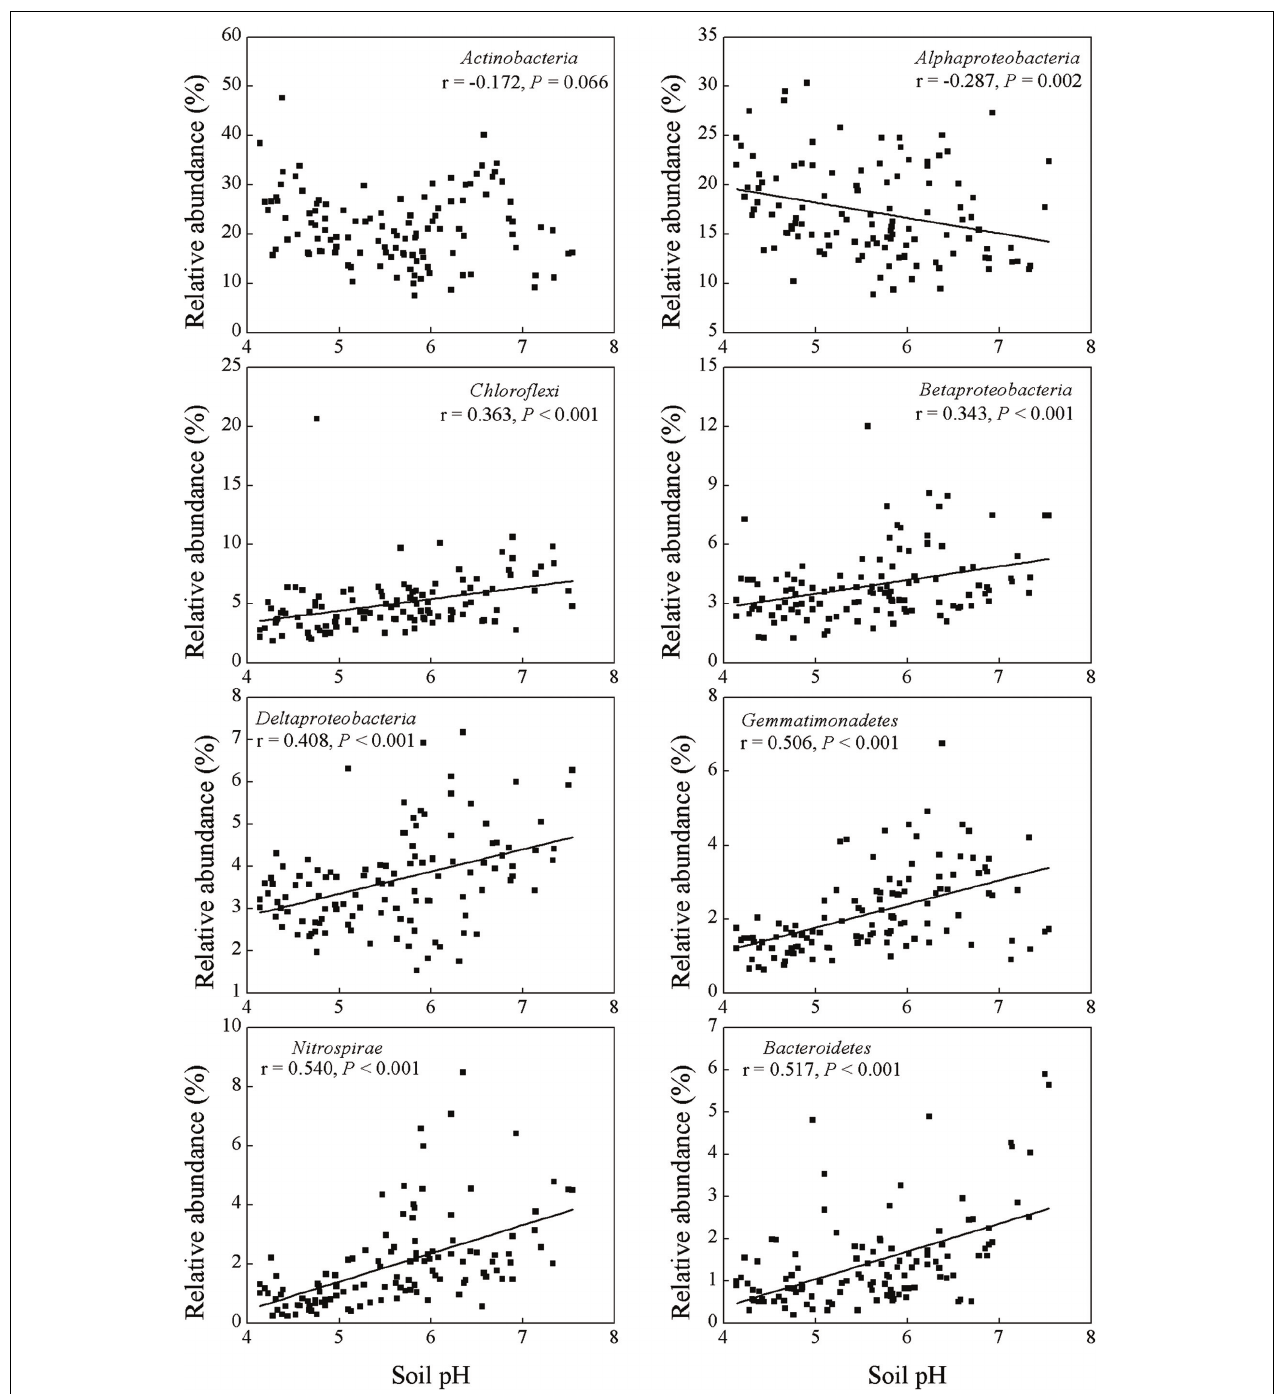
FIGURE 2 | Relationships between the relative abundance of dominant bacterial groups and soil pH.